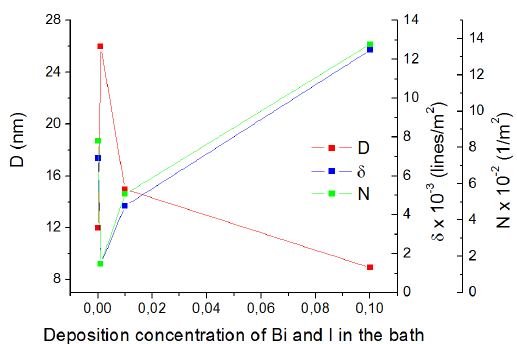
Fig. 2. Average grain size (D), dislocation density (δ), number of crystallites per unit area (N) according to the concentration of Bismuth and iodine in the